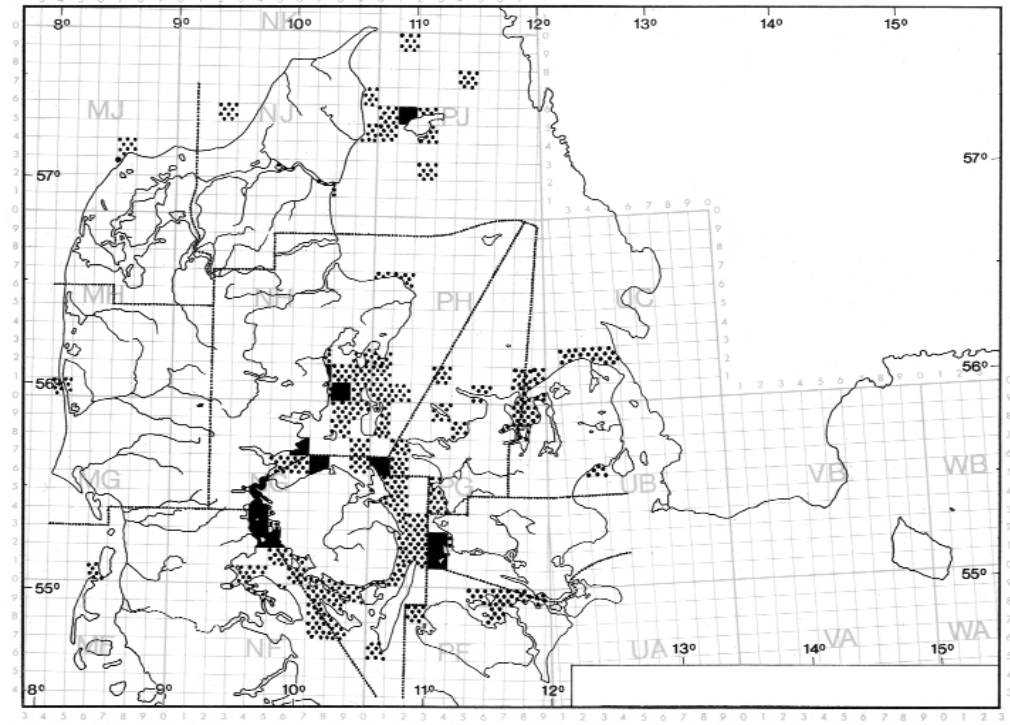
Fig. 2. Distribution of porpoise sightings during 1984-89 (after Kinze 1990). Black squares = sightings of calves during 3 or more